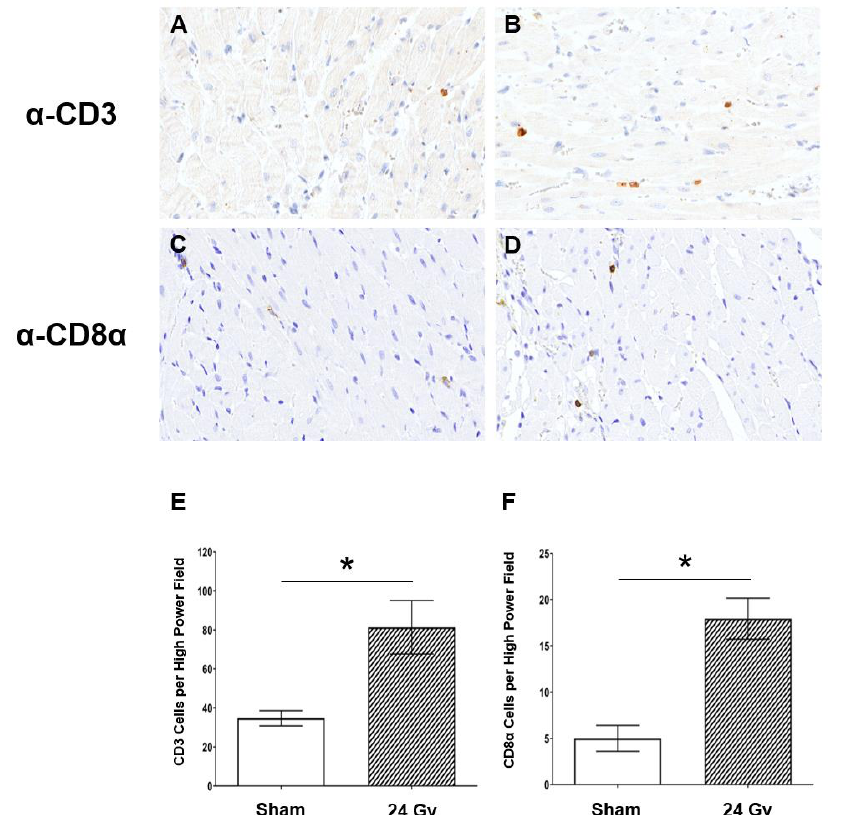
Figure 2. The left ventricles in SS rats have increased T-cell infiltration after localized cardiac radiation compared to sham-treated rats. Adult SS WT female rats were administered either 24 Gy of localized cardiac radiation in one fraction or sham radiation. Representative images of cluster of di ff erentiation 3 (CD3) staining in heart tissue of rats given either ( A ) sham or ( B ) 24 Gy RT. Representative images of CD8 α staining in heart tissue of rats given either ( C ) sham or ( D ) 24 Gy RT. T-cell population staining was quantified as the average number of cells per high power field for CD3 ( E ) and CD8 α ( F ) stained cell populations (values are means ± standard error of the mean (SEM); n = 3–5 / group, * p < 0.01). All images are at 40 × magnification.